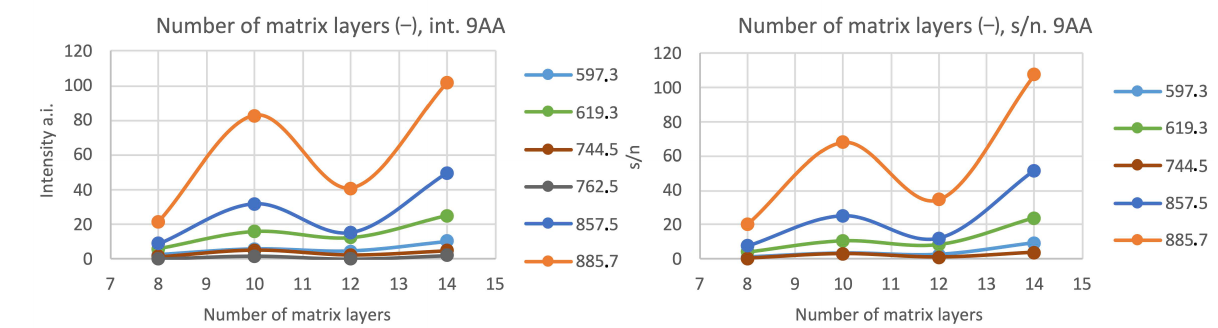
Figure 7. The relationship between the chosen peaks’ intensities and signal-to-noise ratio (s/n) in terms of the number of matrix layers for the negative ionization mode, matrix: 9AA 7 mg/mL 70% EtOH, nozzle position: Z = 25.